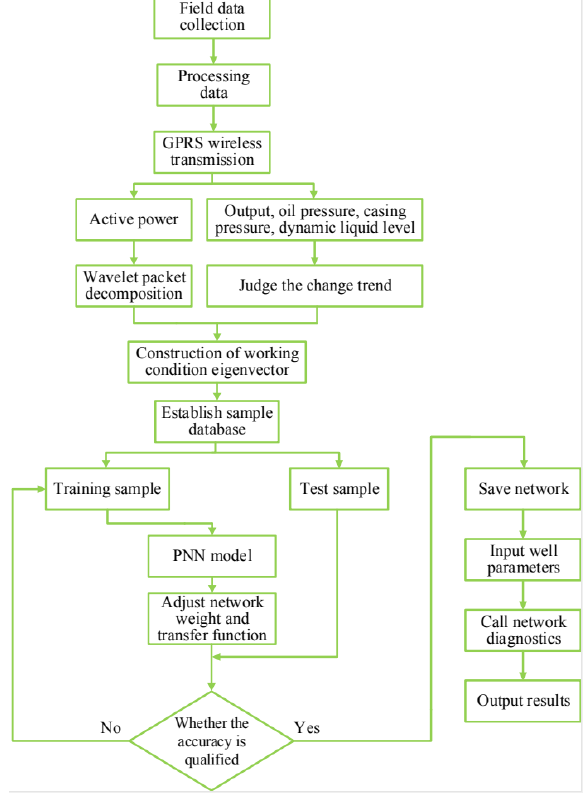
Fig. 3. Flow chart of fault diagnosis frequency analysis of the power signal is done using wavelet packet decomposition and